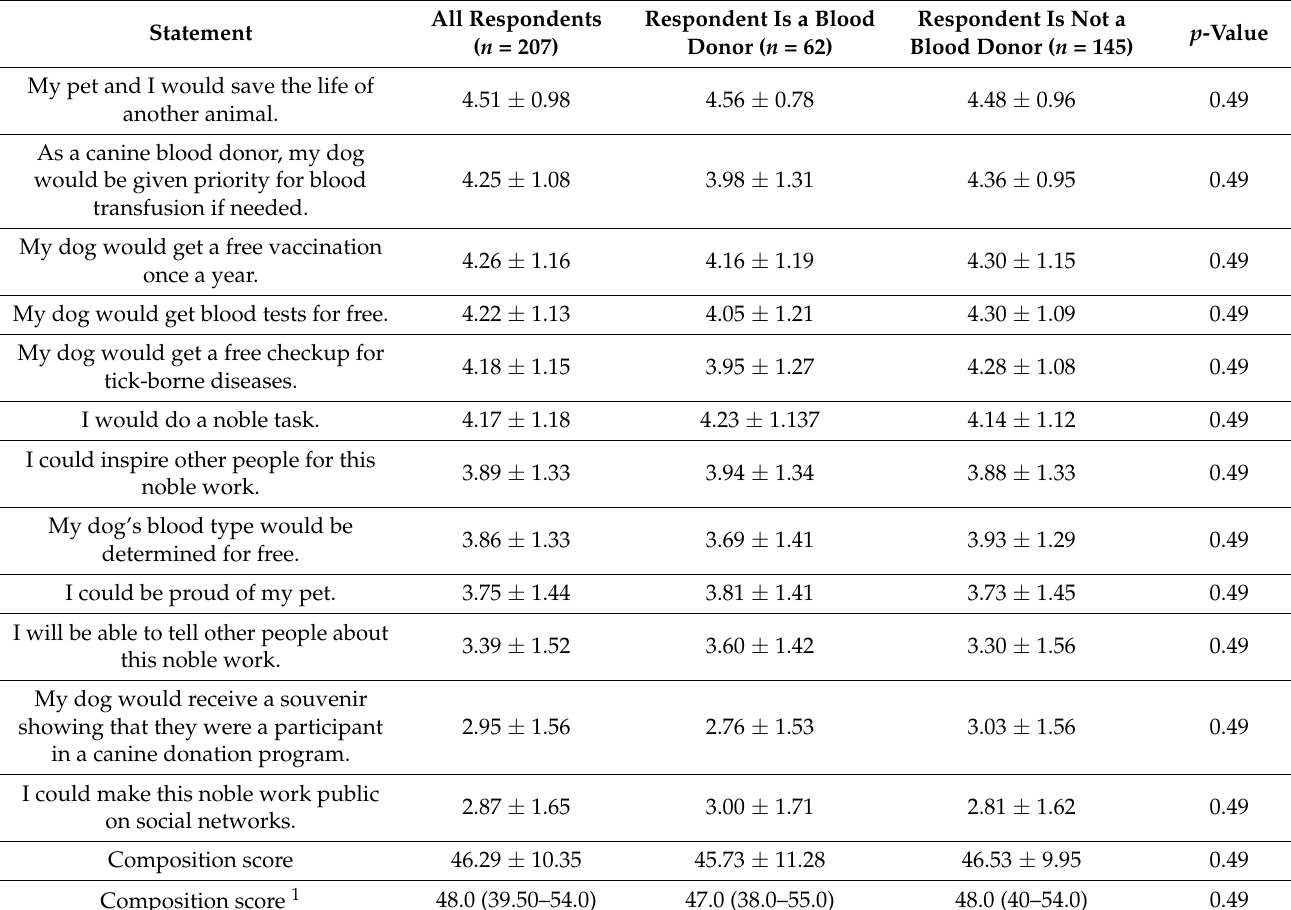
Table A1. The association between the statements from the survey about motivation towards canine blood donation and the respondent being a human blood donor himself/herself. The values represent the means ± standard deviation. Respondent Is a